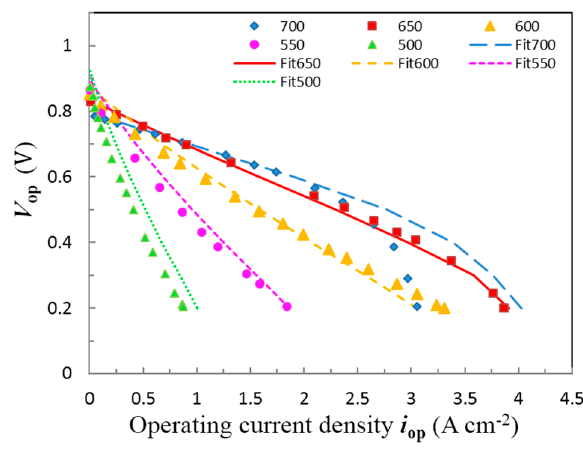
Figure 3. Comparison between the numerical modeling and experiment [13] results at various operating temperatures.